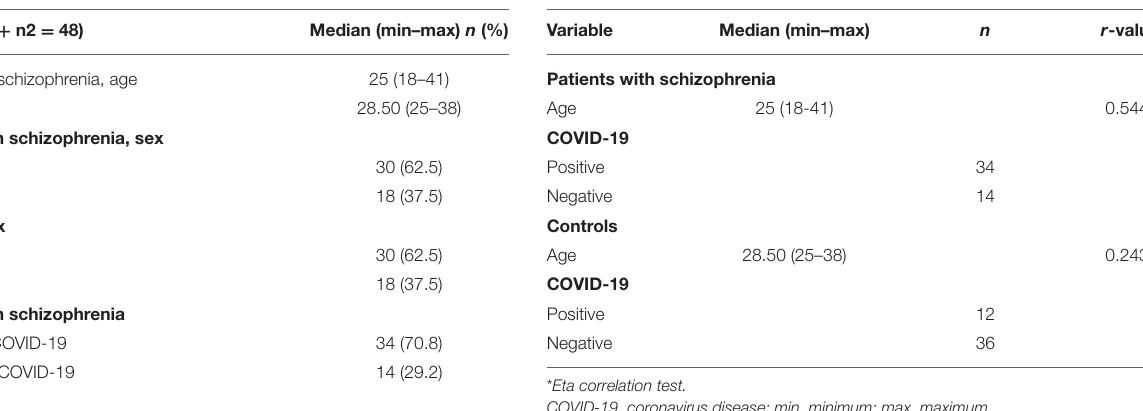
TABLE 1 | Demographic characteristics of patients with schizophrenia and the controls.